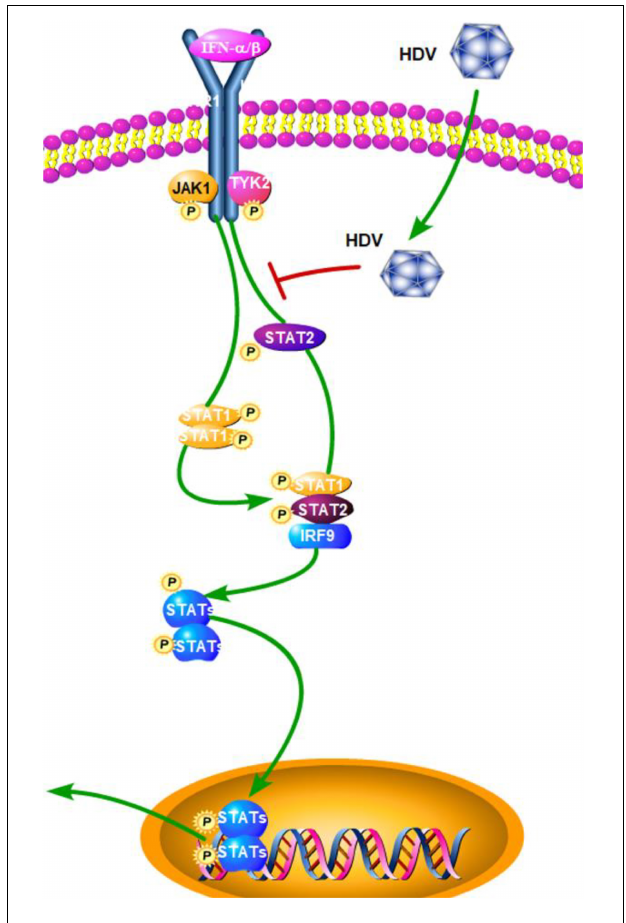
FIGURE 4 | Hepatitis D virus suppression of type I interferon (IFN) response (green arrows indicate the related signaling pathways and T-arrows in red indicate blocking the targets). HDV impairs the IFN- α -stimulated JAK-STAT signaling pathway by inhibiting tyrosine phosphorylation of STAT1, STAT2, and receptor associated kinase